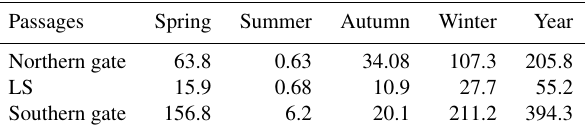
Table 2. Seasonal and annual mean sea ice area flux across different gates (10 3 km 2 ) .